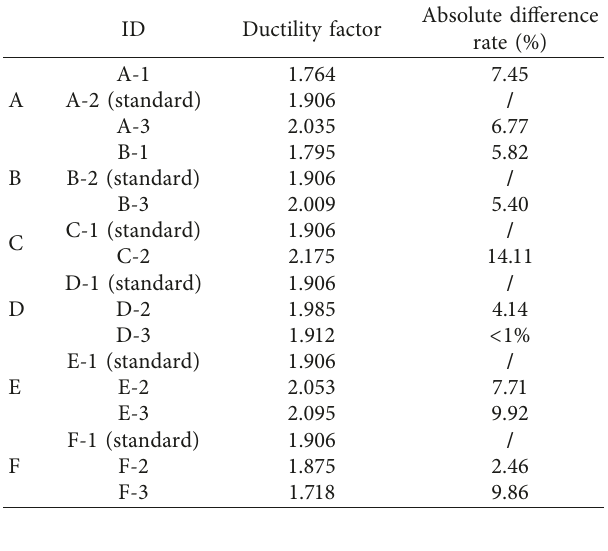
Table 4: Ductility factors of different connections.